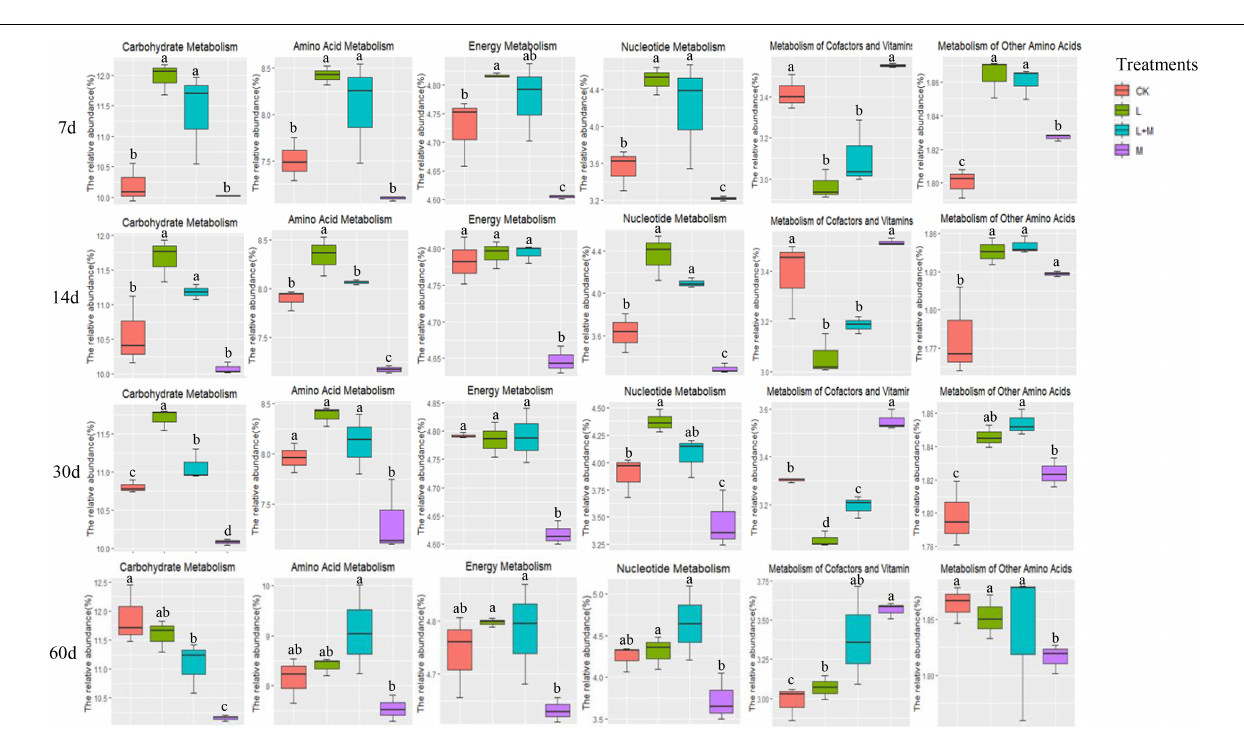
FIGURE 4 | Statistics of additives and ensiling days on the abundance of native grass silage microorganism KEGG pathway. Summary of significant functional shifts predicted using Phylogenetic Investigation of Communities by Reconstruction of Unobserved States (PICRUSt). For each KEGG pathway, the second level of the predicted functional shift is shown with respect to the fermentation processes and additive treatments. a–d indicates significant differences between different additive treatments in the same silage period at p < 0.05. CK, no additive control; L, lactic acid bacteria; M, molasses; L + M, lactic acid bacteria +